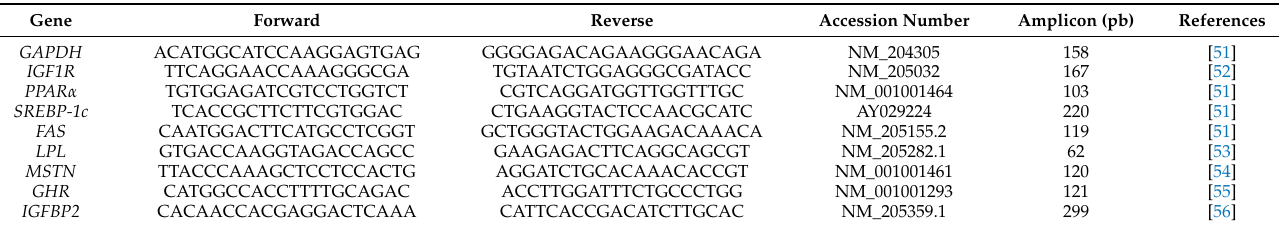
Table 2. Primers for gene expression by RT-PCR